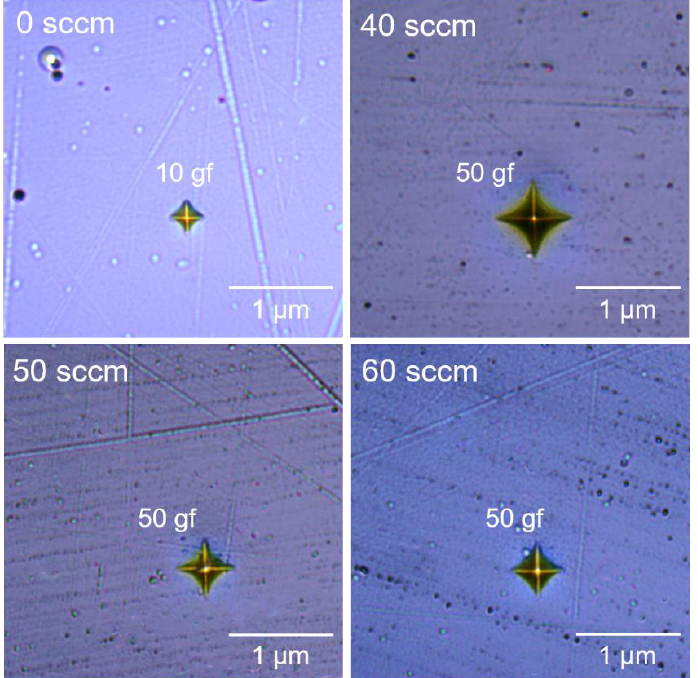
Figure 8. The optical micrograph of Vickers indentation of the TiAlN coatings deposited under var-